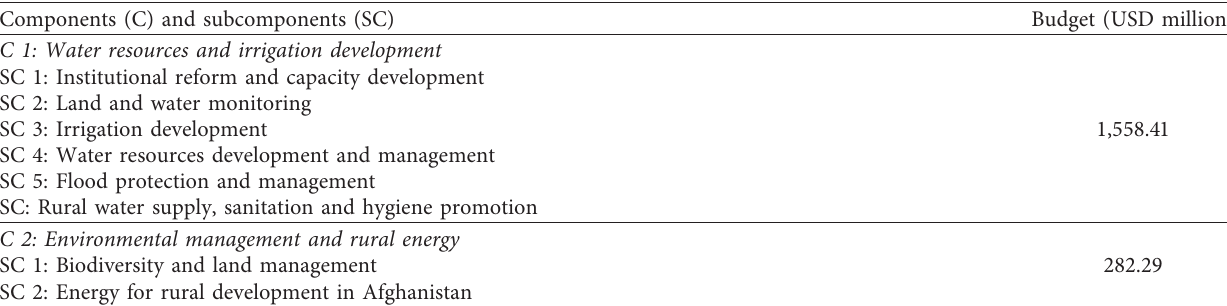
Table 6: Components and subcomponents of